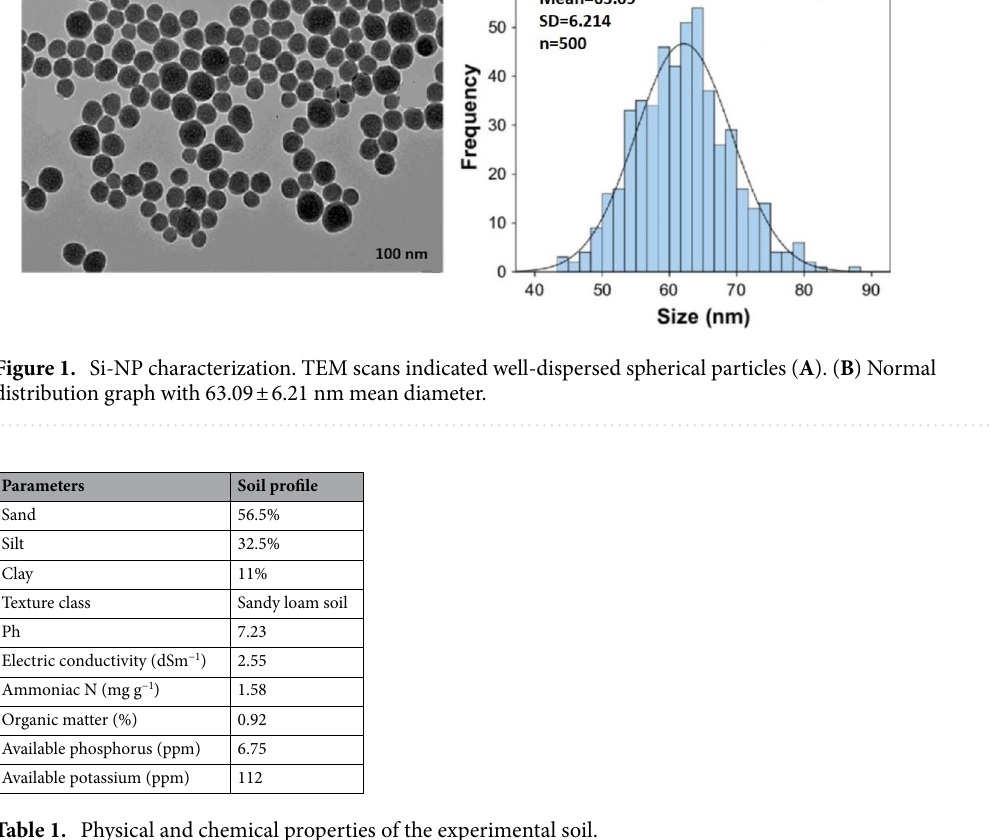
Table 1. Physical and chemical properties of the experimental